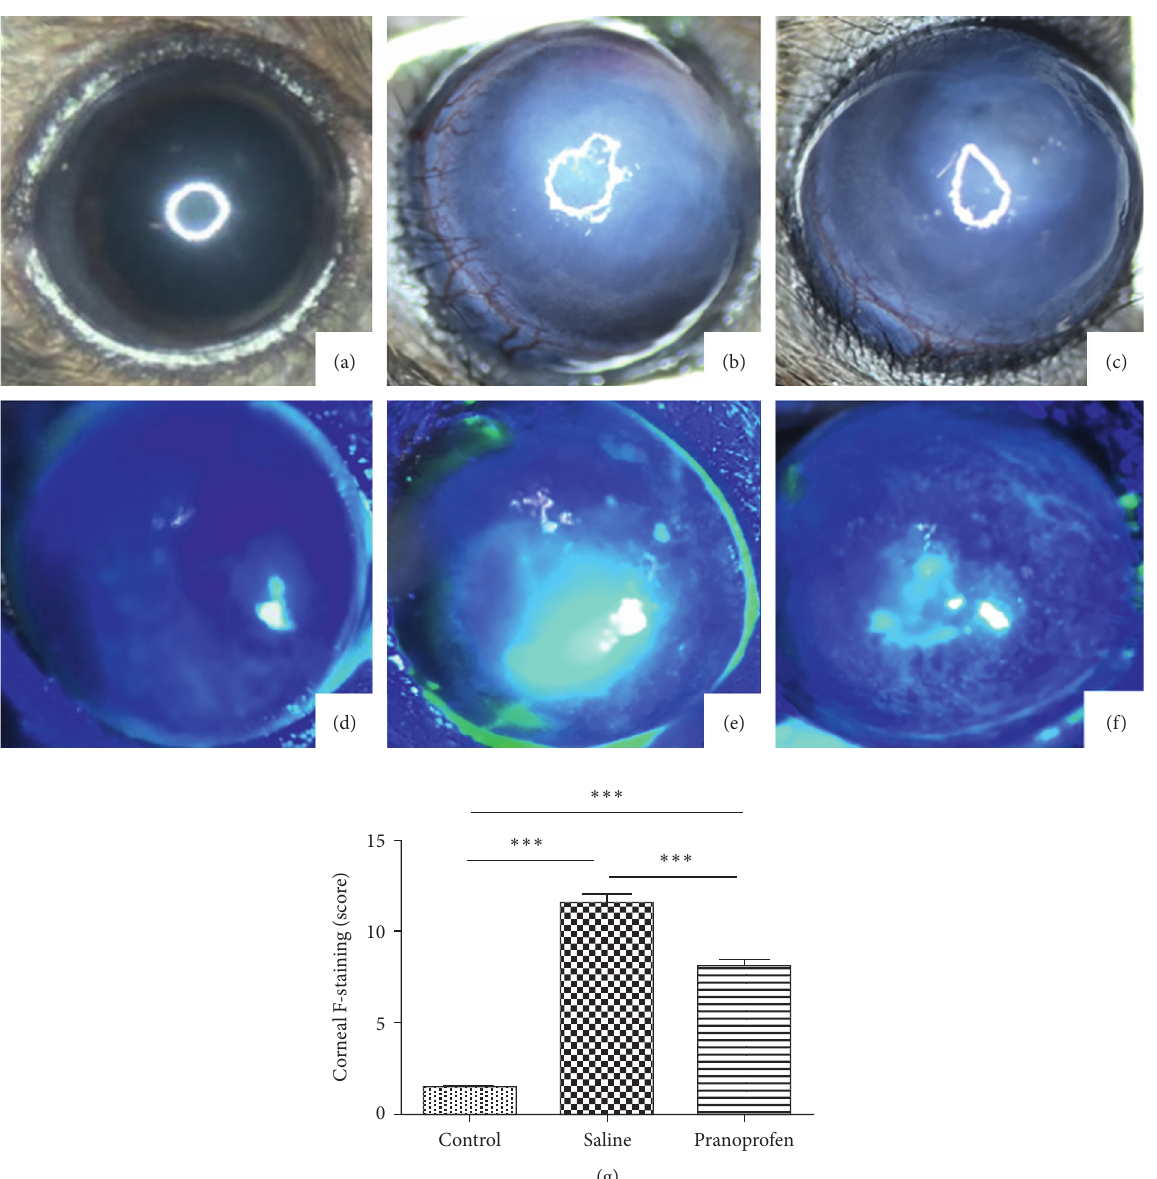
Figure 1: Stereoscopic microscope observation. (upper images) Stereomicroscopic observations on a 5th day in, respectively, control group (a), saline group (b), and pranoprofen group (c). Corneal fluorescein sodium staining and scoring. Staining for corneal fluorescein sodium in the (d) control group, (e) saline group, and (f) pranoprofen group, respectively. (g) Corneal fluorescein staining scores. Data are shown as mean ± SD; ∗∗∗ P < 0 .